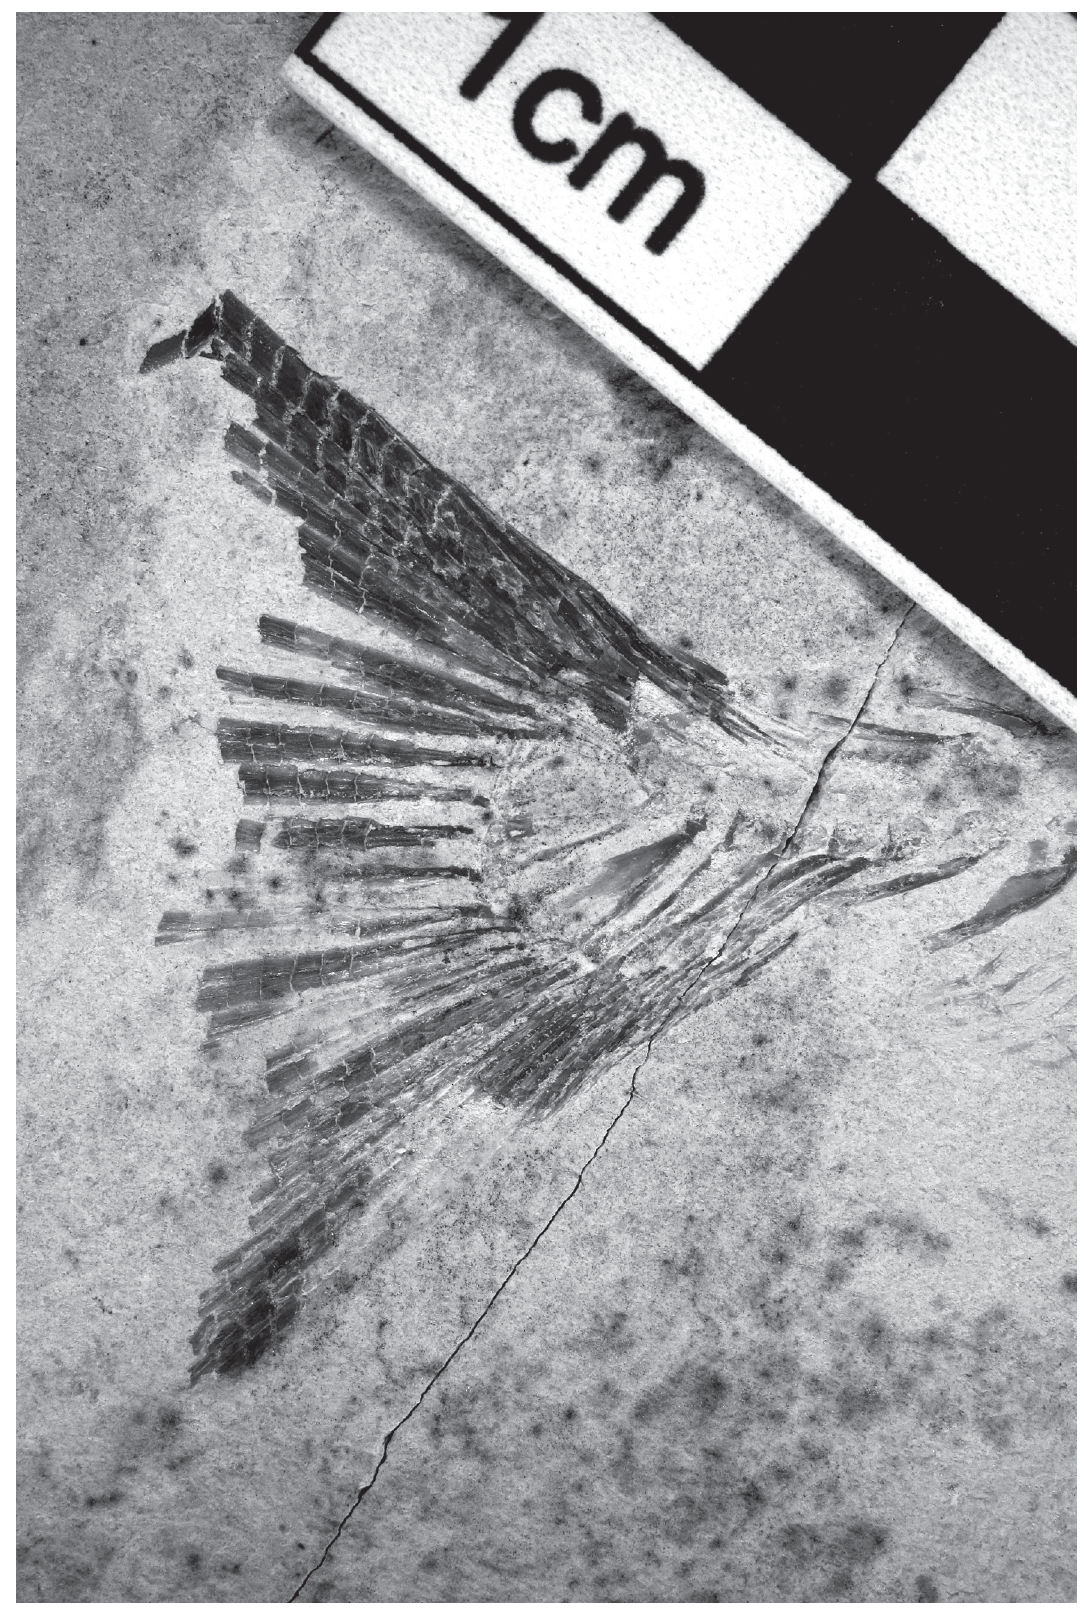
Fig. 8. Libanopycnodus wenzi gen. et sp. nov., holotype, tail region (CLC